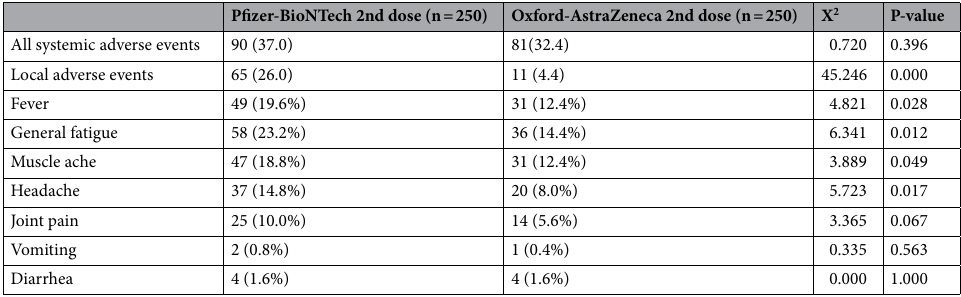
Table 4. Comparison of local and systemic adverse events between second dose of both studied